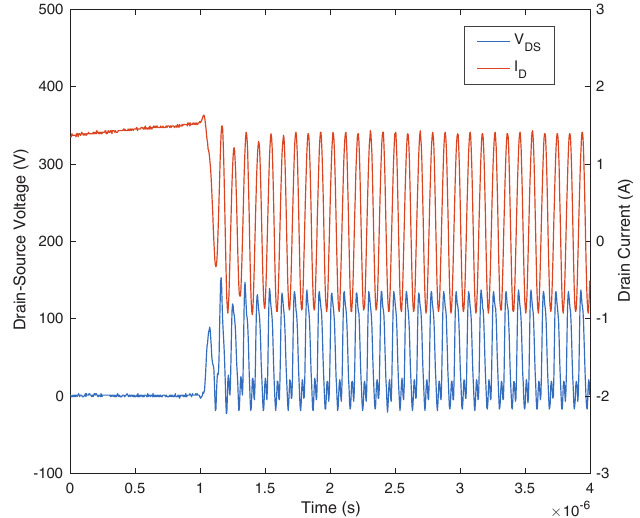
Figure 3. The type I oscillation waveforms of the I D and V DS (Polarities defined in Figure 2).